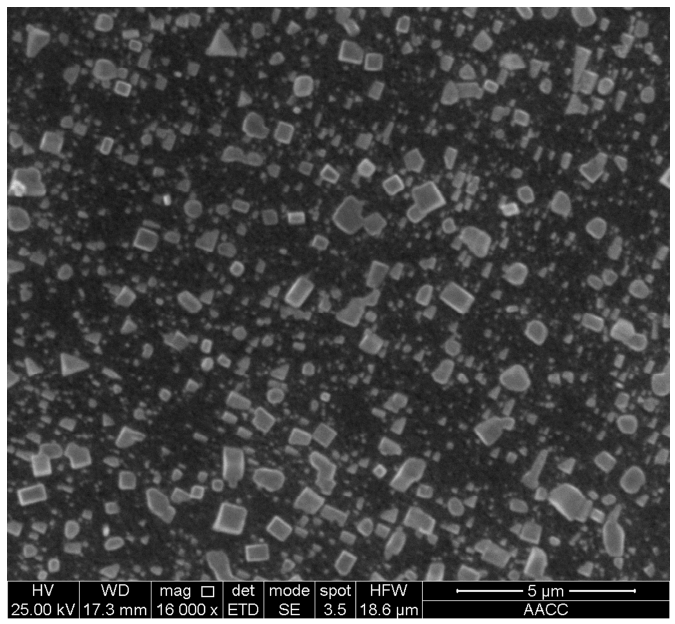
Figure 3. SEM backscattered electron image showing NaCl crystals distributed on the surface of hardened silica sol gel (aged 28 days). The scale bar in the lower right corner is 5 μ m. Table 1. Particle size ranges and viscosities for silica sol and two grouts commonly used in geotechnical engineering areas.